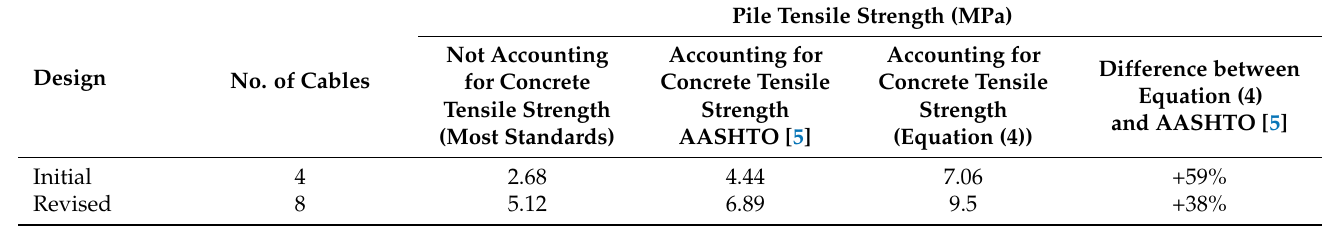
tensile strength at least 38% higher than that of AASHTO [5]. Table 3. Pile Tensile